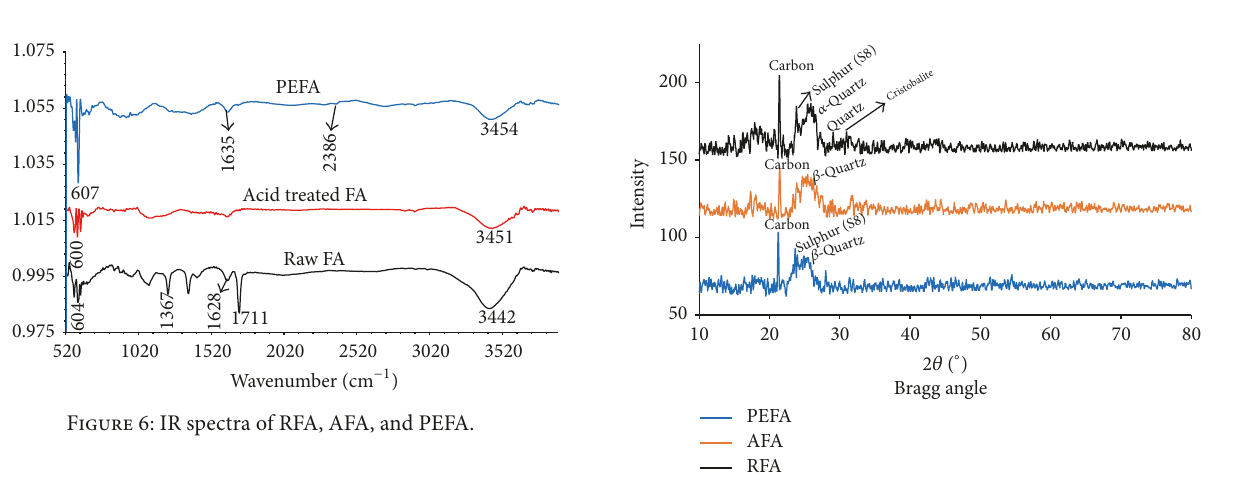
Figure 5: Polyelectrolyte-coated FA (a) SEM micrographs (view field: 500 and 150 𝜇 m; voltage: 10kV; resolution: 382x and 1.27kx); (b) EDX spectrum.